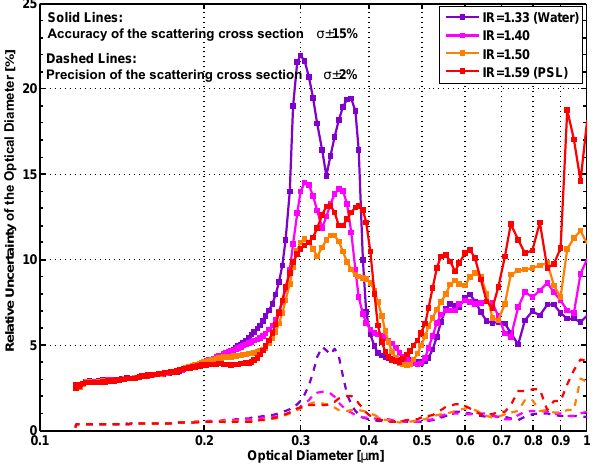
Figure 8. Relative uncertainty of the optical sizing by the WELAS as a function of optical diameter and for dry particles with different indices of refraction. The accuracy estimate (solid lines) is based on error propagation calculations for a fixed accuracy of ± 15% for the measured scattering cross sections (note: the y axis shows the absolute value of the larger relative size change when disturbing the scattering cross section by ± its uncertainty). Additionally, the precision of the optical sizing (dashed lines) is